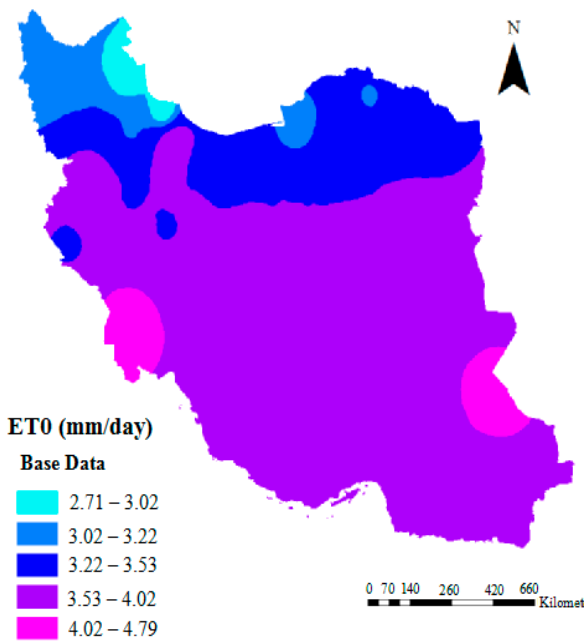
Figure 3. Spatial distribution of the daily reference evapotranspiration (ET 0 ) in the base period. Table 1. Change percentages of the ET 0 predicted for the period from 2011 to 2045 under the A1B